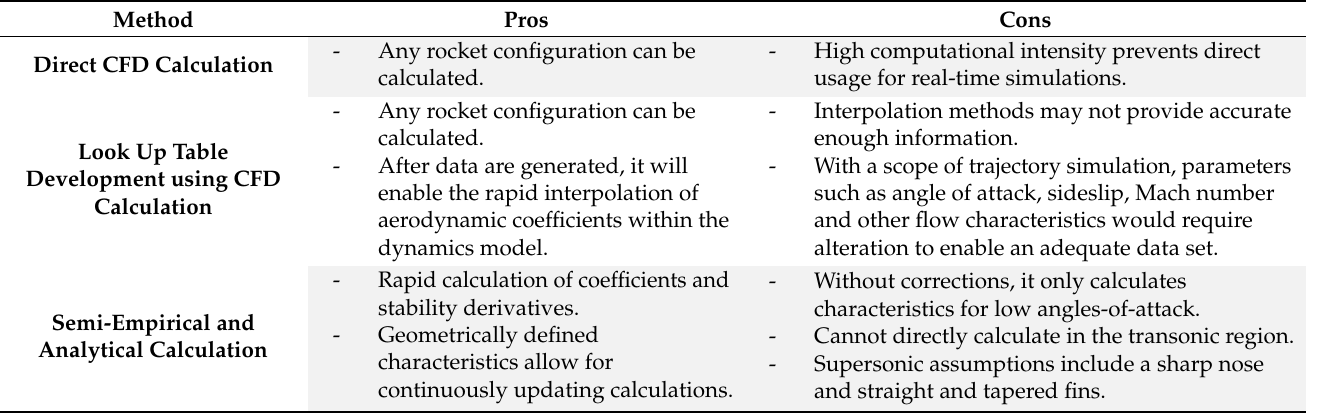
Table 1. Comparison of rigid-body aerodynamic coefficient calculation